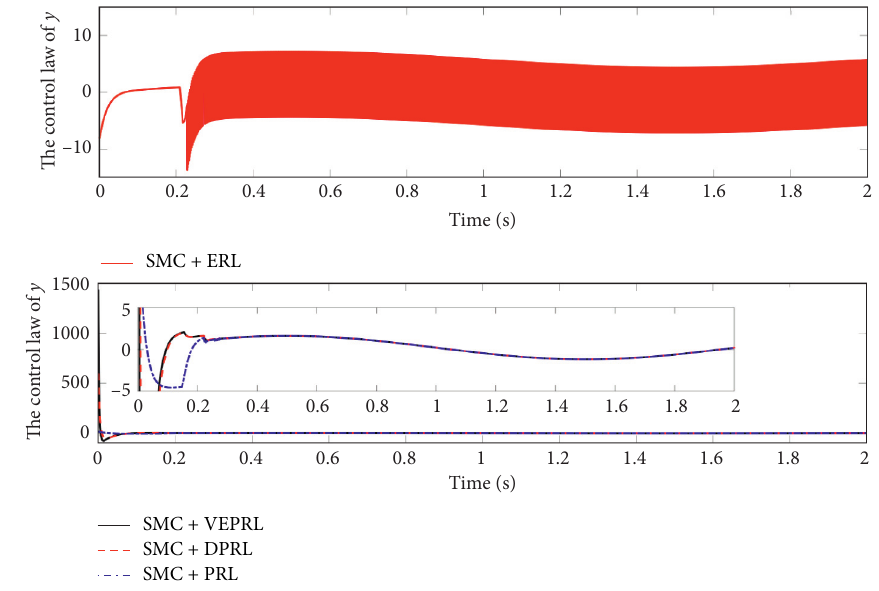
Figure 8: The control law of ( y ) under SMC.